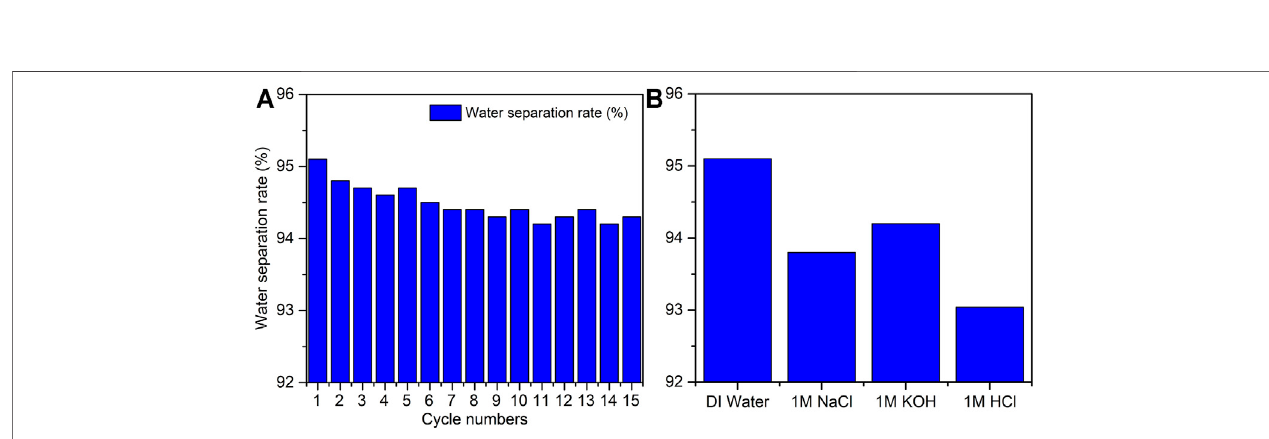
FIGURE 9 | (A) Water separation ef fi ciency from the water – oil mixture using the zeolite-coated laser-structured SS-100 meshes during 15 separation cycles. (B) Separation ef fi ciencies of the zeolite-coated laser-structured SS-100 mesh in deionized (DI) water, 1 M of NaCl, 1 M of KOH, and 1 M of HCl.